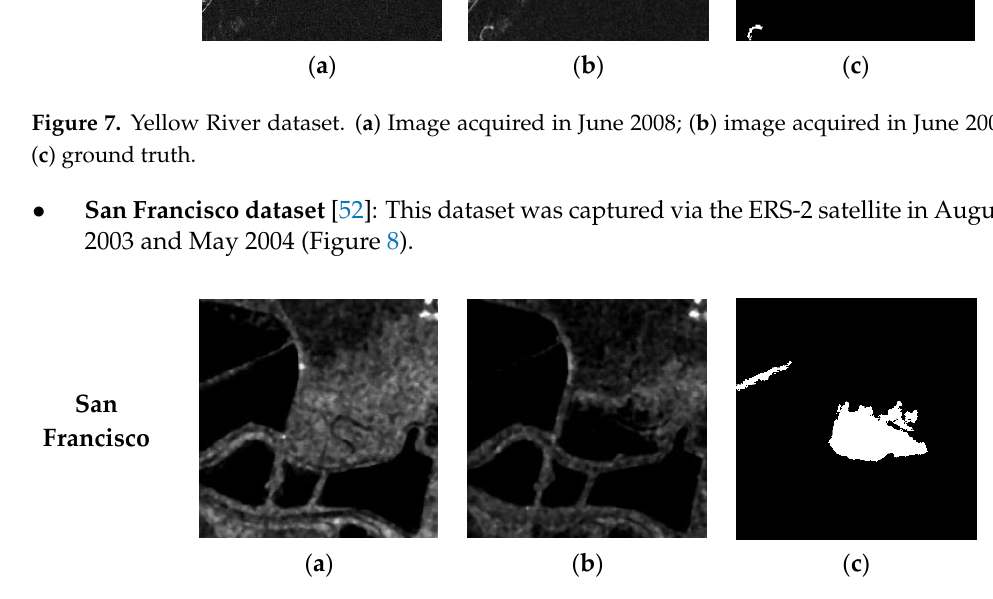
Figure 8. San Francisco dataset. ( a ) Image acquired in August 2003; ( b ) image acquired in May 2004; ( c ) ground truth.